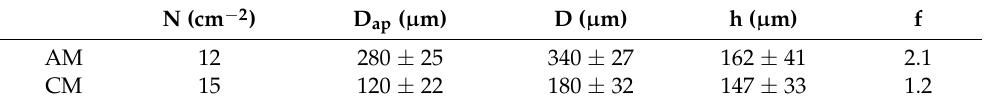
Figure 5. Optical microscope observations of the stable pits formed after chronoamperometry tests performed in 0.5 M NaCl solution at a fixed potential of +500 mV versus E corr for: ( a , c ) CM samples; ( b , d ) AM samples; ( e ) scheme of a pit with the parameters used for the analysis. Table 3. Average values (4 tests, i.e., about 80 pits analysed) obtained for the different parameters that are characteristic of the stable pits for both the AM and CM samples of MSS. N = number of pits per cm 2